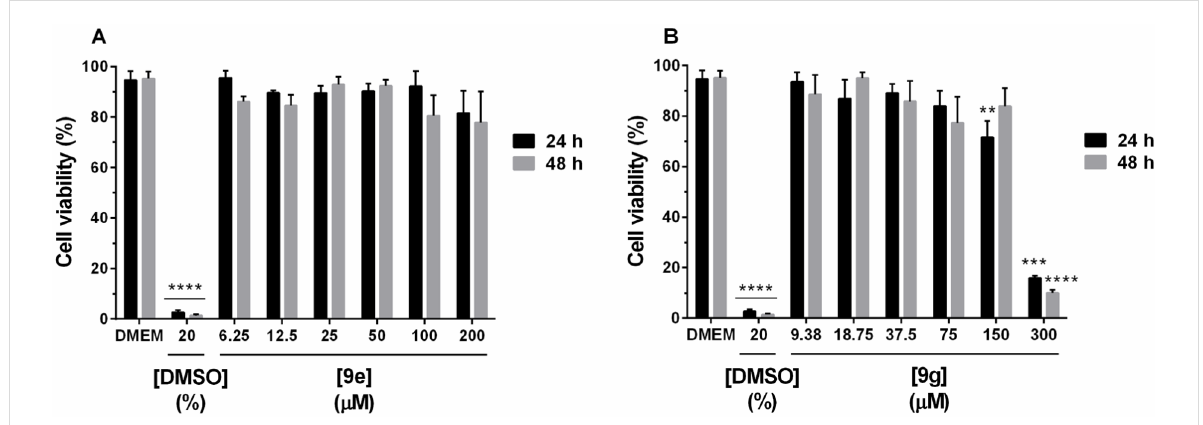
Figure 4: Cell viability of human fibroblast exposed to compounds 9e (A) and 9g (B) for 24 and 48 hours. The values are expressed as mean ± SEM. **** p < 0.0001, ** p < 0.005 and *** p < 0.001 versus DMEM control group.